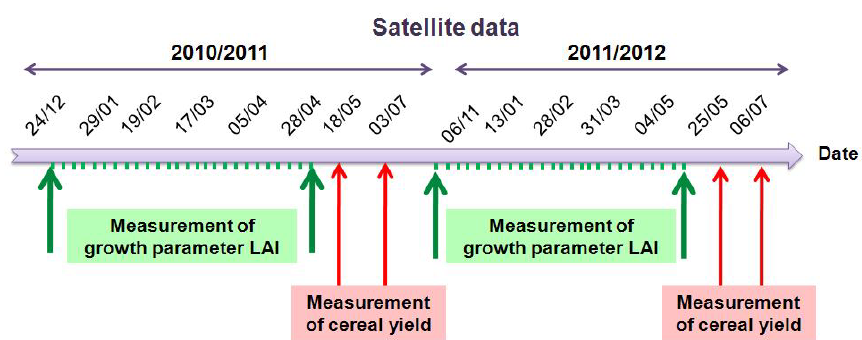
Figure 3. Overview of the satellite and ground measurements.